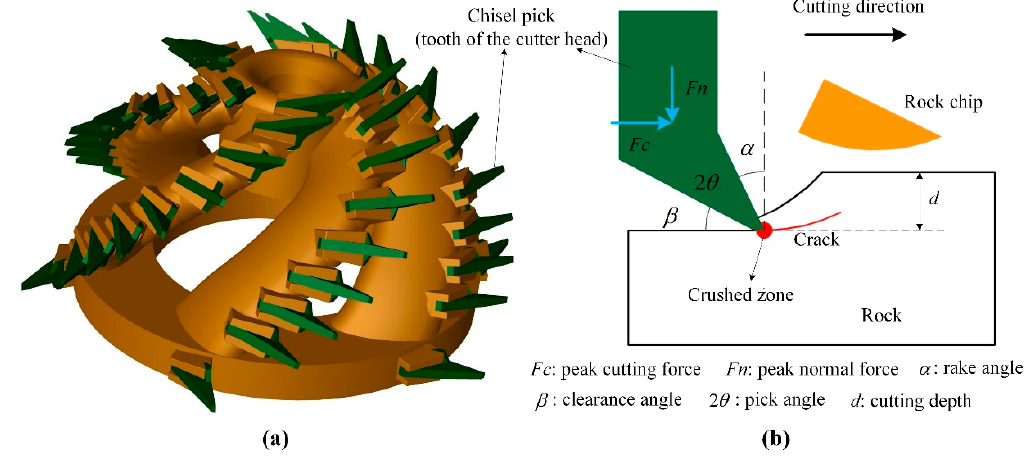
Figure 1. ( a ) Cutter head of the cutter suction dredger, and ( b ) parameters and forces in rock cutting.